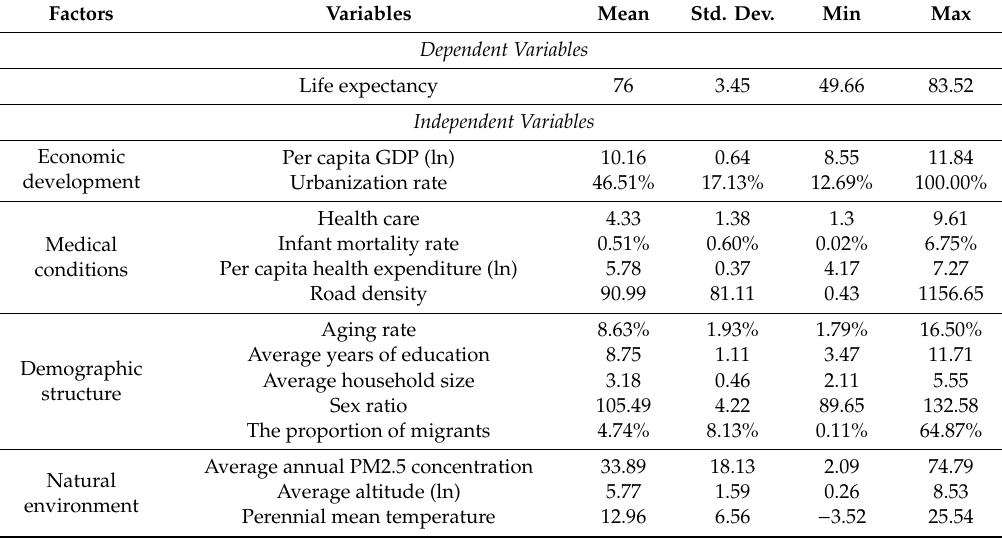
Table 1. Definitions and descriptive statistics of